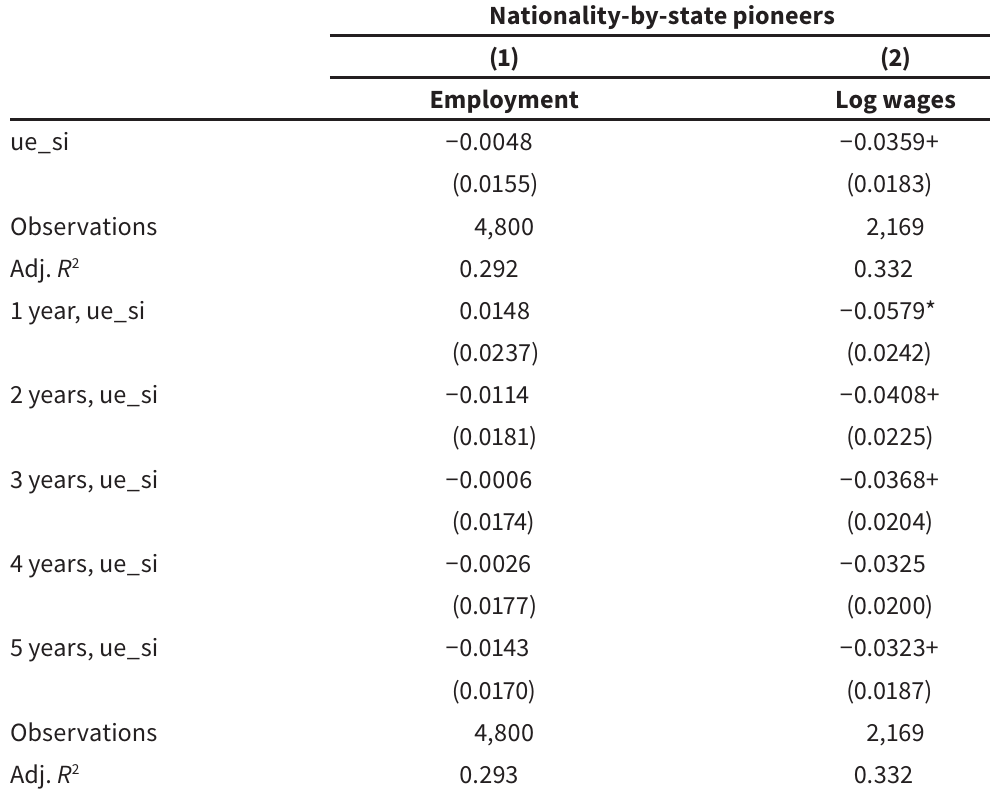
State unemployment estimates using pioneers Nationality-by-state pioneers (1) (2) Employment Log wages −0.0048